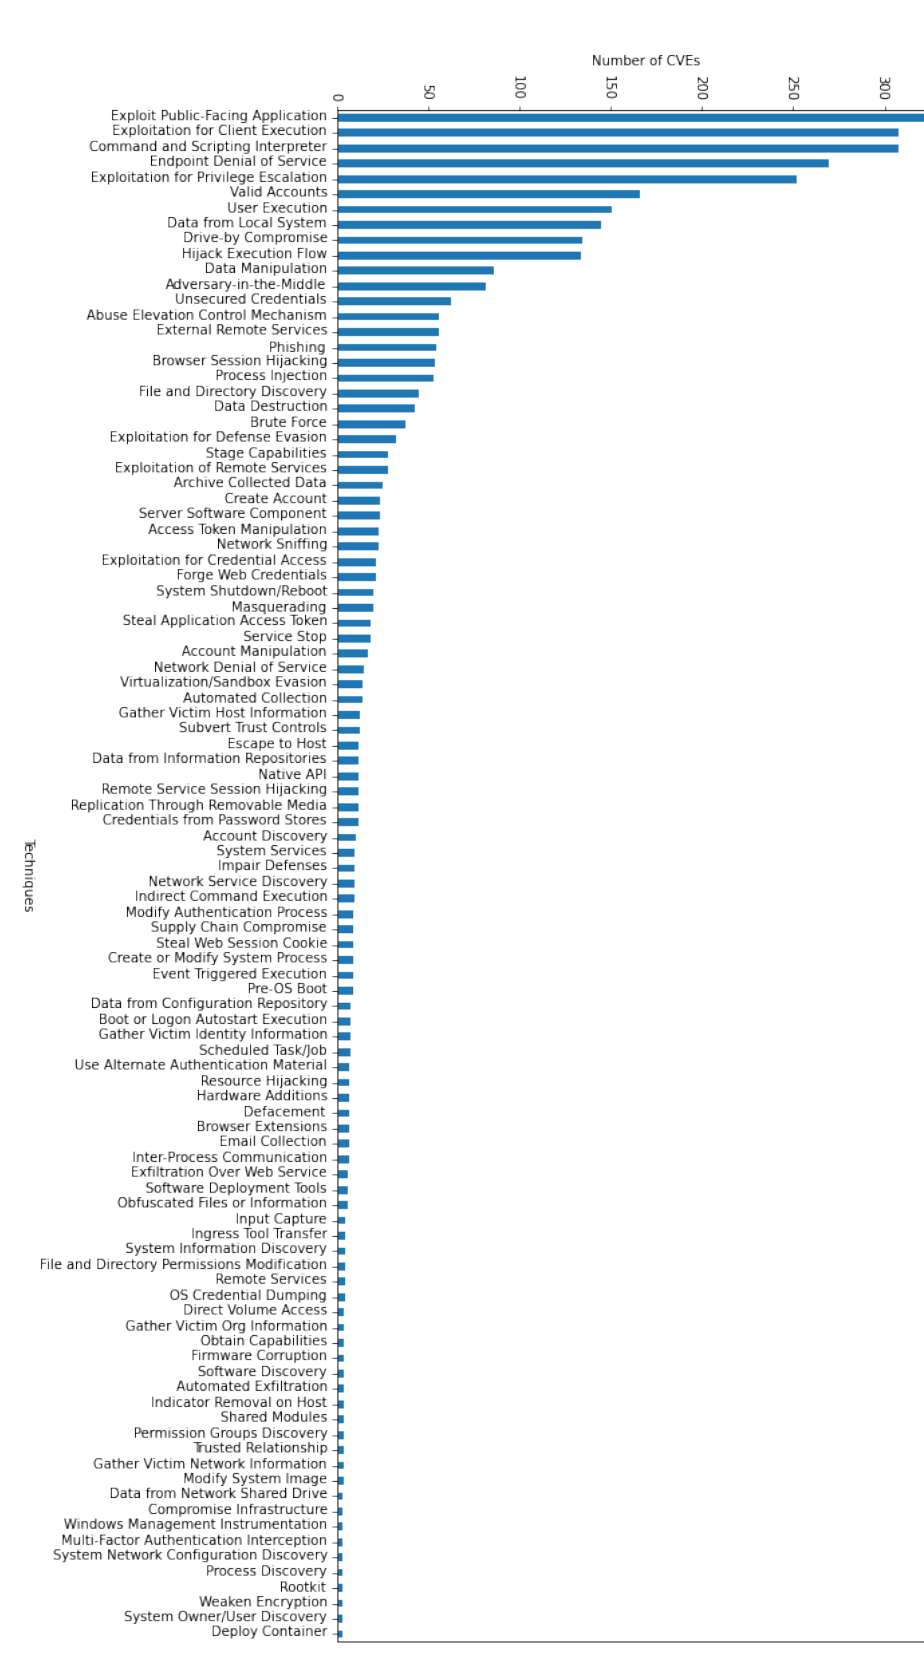
Figure 1. The distribution of CVEs among